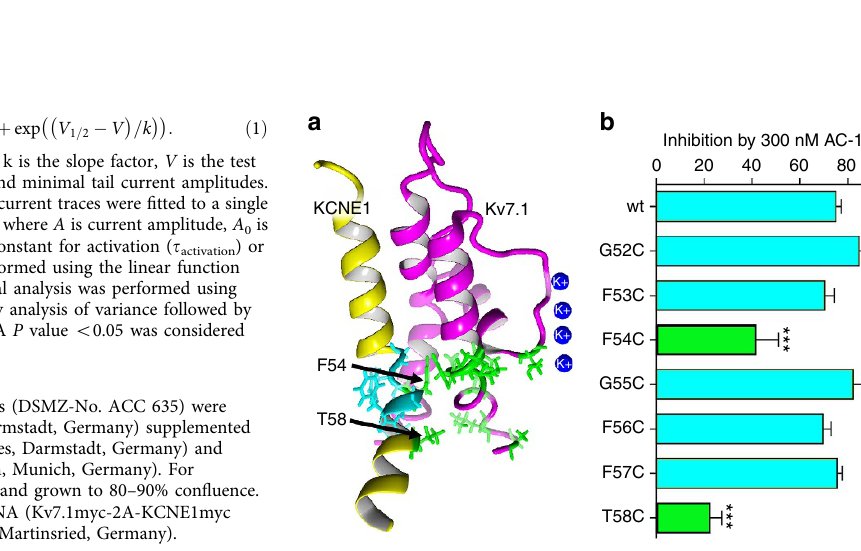
Figure 7 | Single point mutagenesis of the transmembrane region of KCNE1. ( a ) Location of the transmembrane region of KCNE1 (KCNE1-TM) in a Kv7.1/KCNE1 channel complex. ( b ) Inhibition of Kv7.1/KCNE1 channel complexes by 300nM AC-1. Single point mutations were introduced as indicated and inhibition was determined as percent change in current amplitude at the end of a depolarizing test pulse to þ 40mV ( n ¼ 3–5, ± s.e.m.; one-way analysis of variance, Dunnet’s post hoc test; *** P o